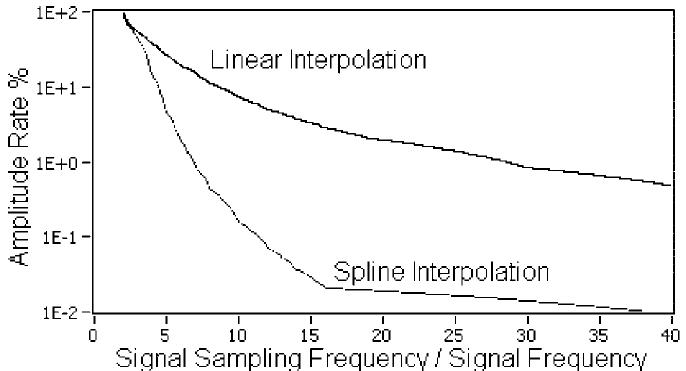
Fig. 18. Noise level for different sampling frequencies and